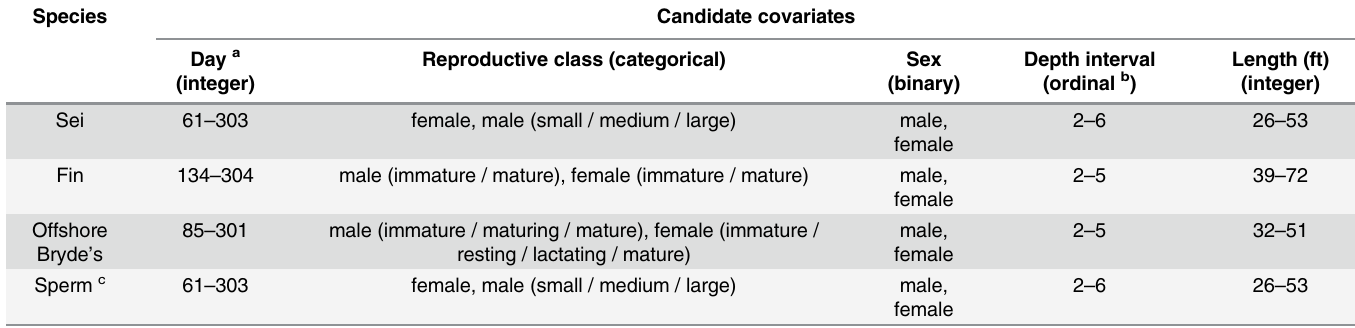
Table 2. Candidate covariates for regression models of the total number of unhealed bitemarks, and the proportion of unhealed bitemarks that were recent on four whale species. Species